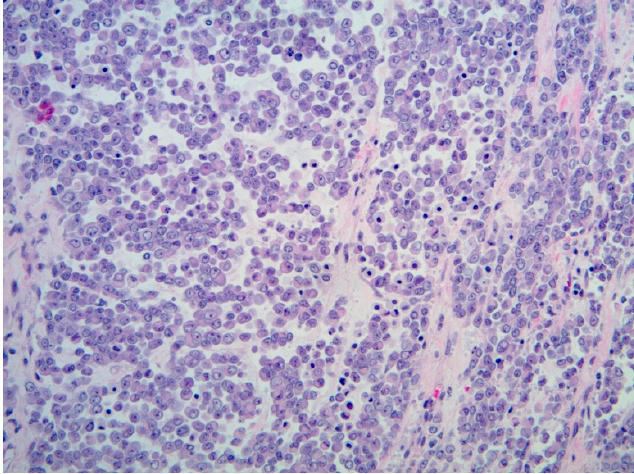
Figure 7. Malignant rhabdoid tumor (H&E, 20× magnification). Typical rhabdoid cells, with eccentric nuclei with prominent nucleoli, and eosinophilic cytoplasm, with discohesive architecture.